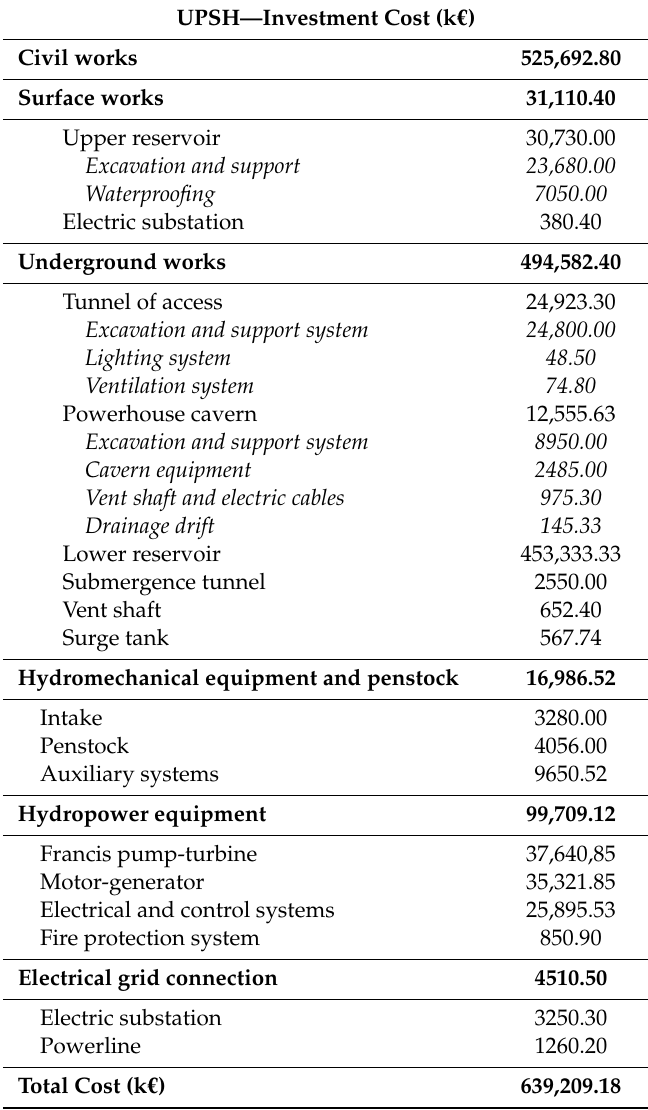
Table A1. Assessment of the investment costs of a UPSH plant, considering an FT with 219 MW of output power and a DTC of 8 h. Civil works, hydromechanical equipment and penstock, hydropower equipment, electric substation and grid